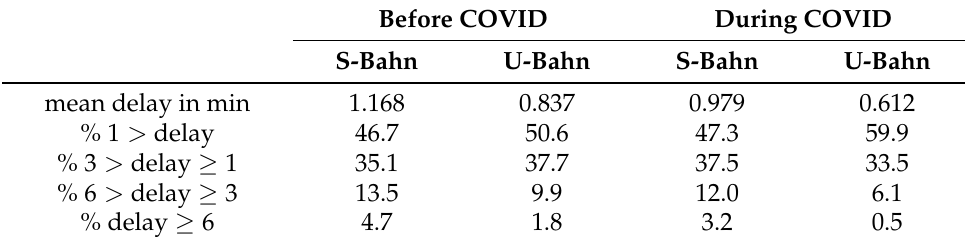
Table 4. Changing Public Transit Delay before and during